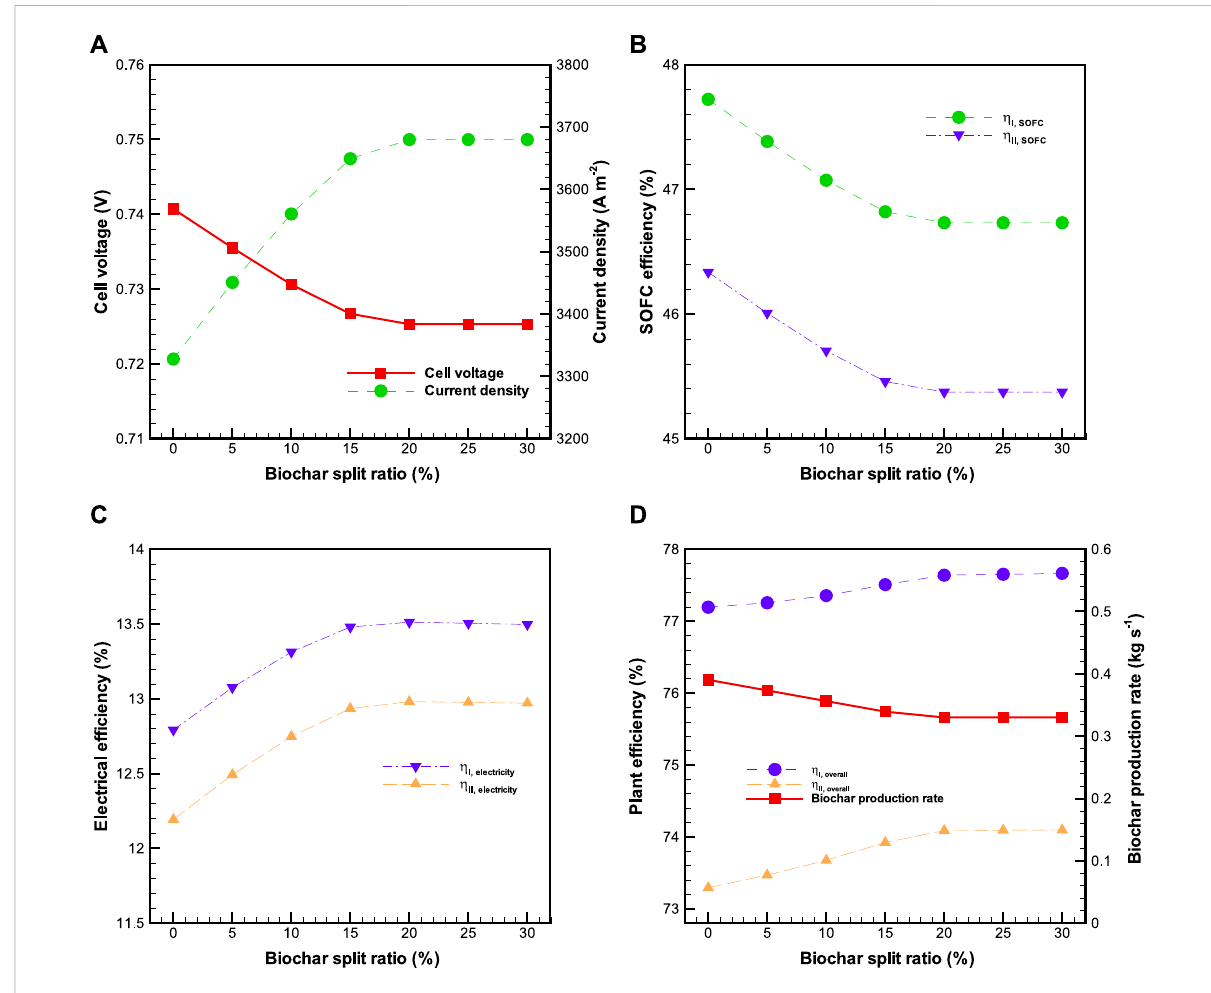
FIGURE 8 Effects ofbiocharsplit ratio ( R biochar )onthe BP-SOFC-CHPsystem: (A) SOFC cell voltage andcurrentdensity, (B) SOFC ef fi ciency, (C) electrical ef fi ciency, and (D) overall system ef fi ciency and biochar production rate.